Question: Identify the chart type used in this figure.
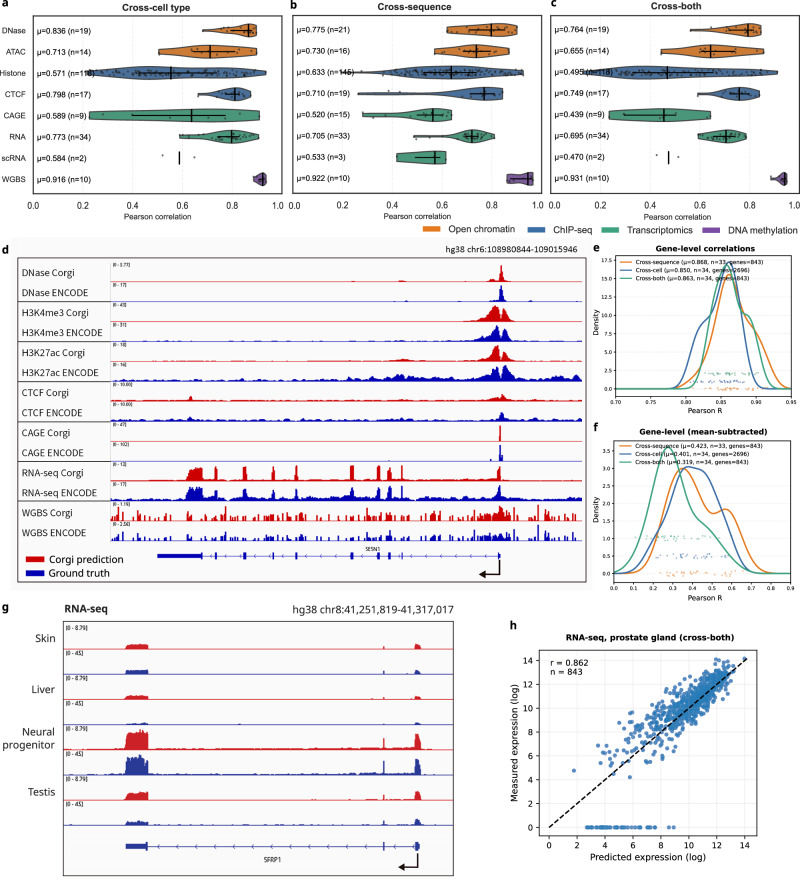
Answer: scatter